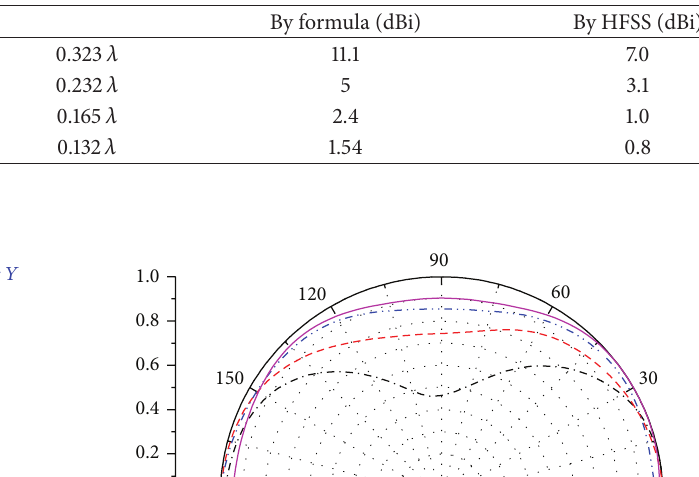
Table 3: Comparison of gain variations.